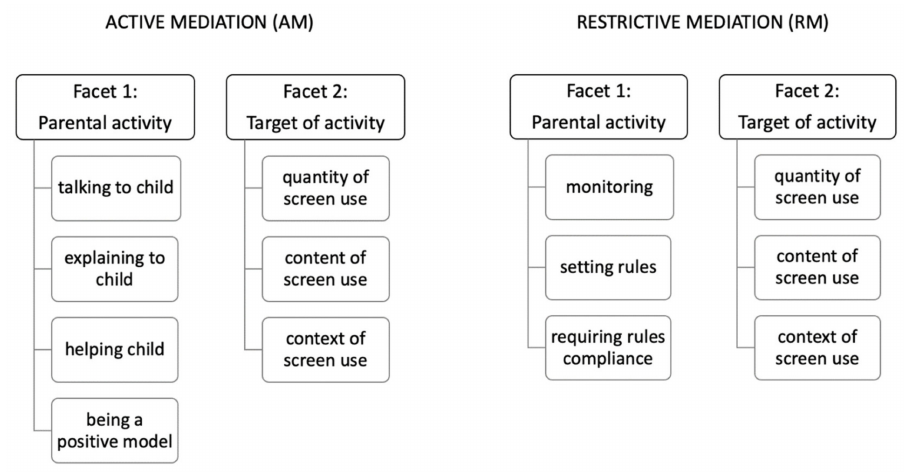
Figure 1. Facets of Active and Restrictive Mediation subscales.